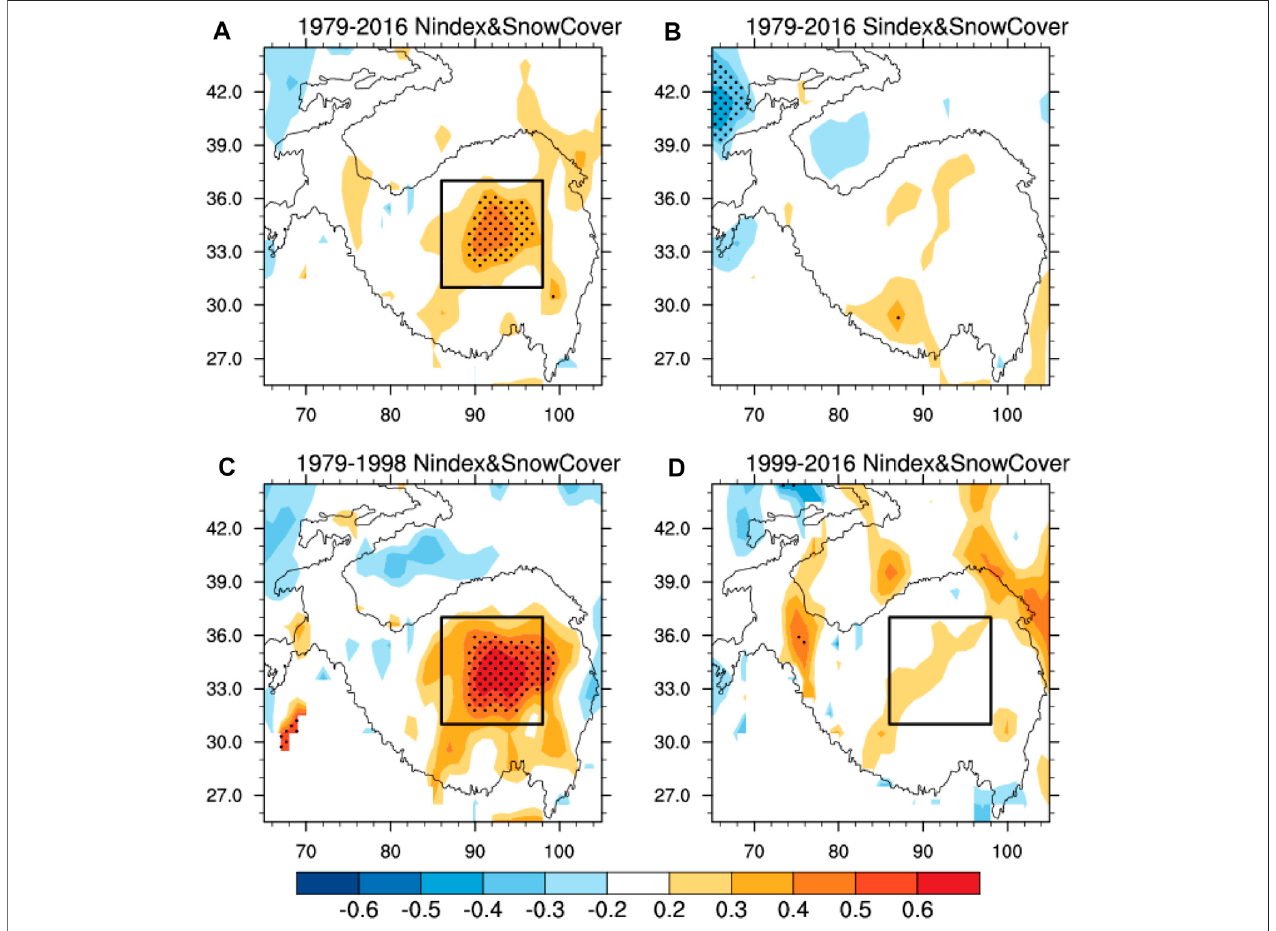
FIGURE1| CorrelationcoefficientsbetweentheONDJsnowcoveranomaliesovertheTibetanPlateauandtheNindexduring1979 – 2016 (A) ,1979 – 1998 (C) ,and 1999 – 2016 (D) , and those between the ONDJ snow cover anomalies over the Tibetan Plateau and the Sindex during 1979 – 2016 (D) . The dotted regions represent the correlation coef fi cients signi fi cant at the 95% con fi dence level. The box denotes the key region over the Tibetan Plateau that is used to de fi ne the SCI.